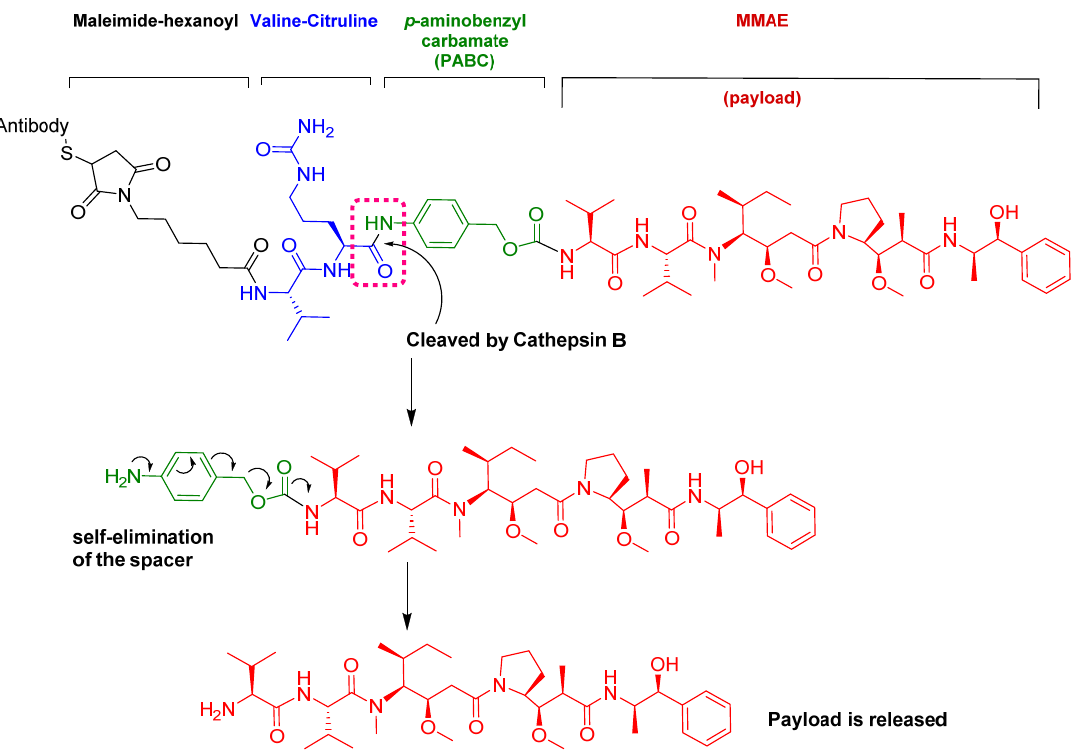
Figure 9. Mechanism of payload release in ADCs with Val-Cit linker and p-aminobenzyl carbamate as a spacer [67]. MMAE; monomethyl auristatin